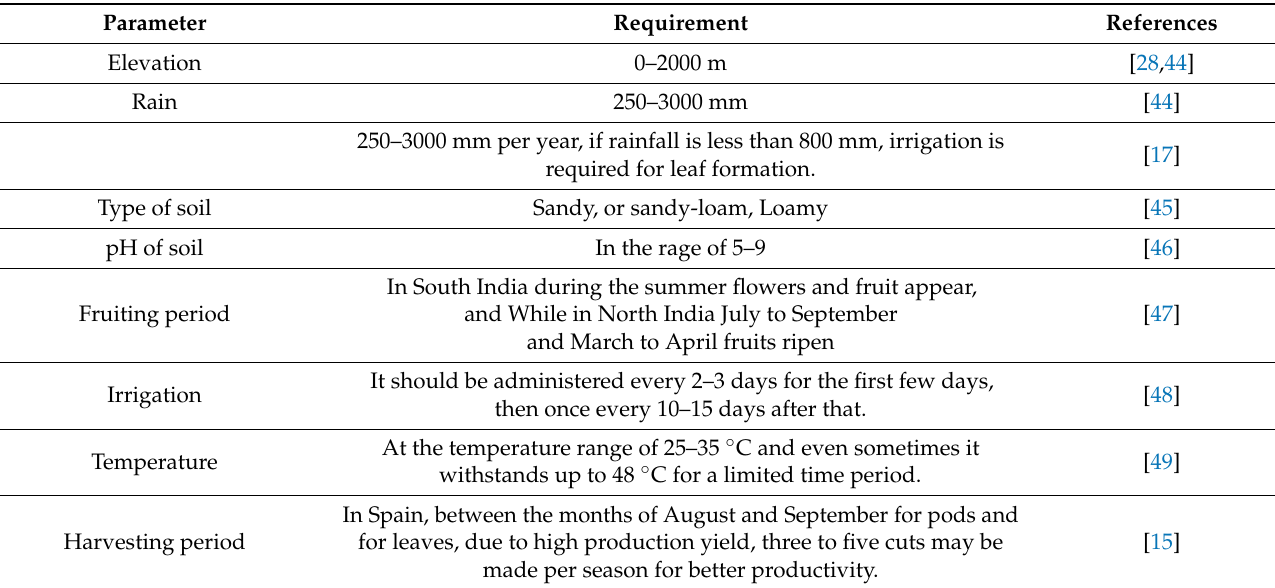
Table 3. Different parameters for cultivation of M. oleifera